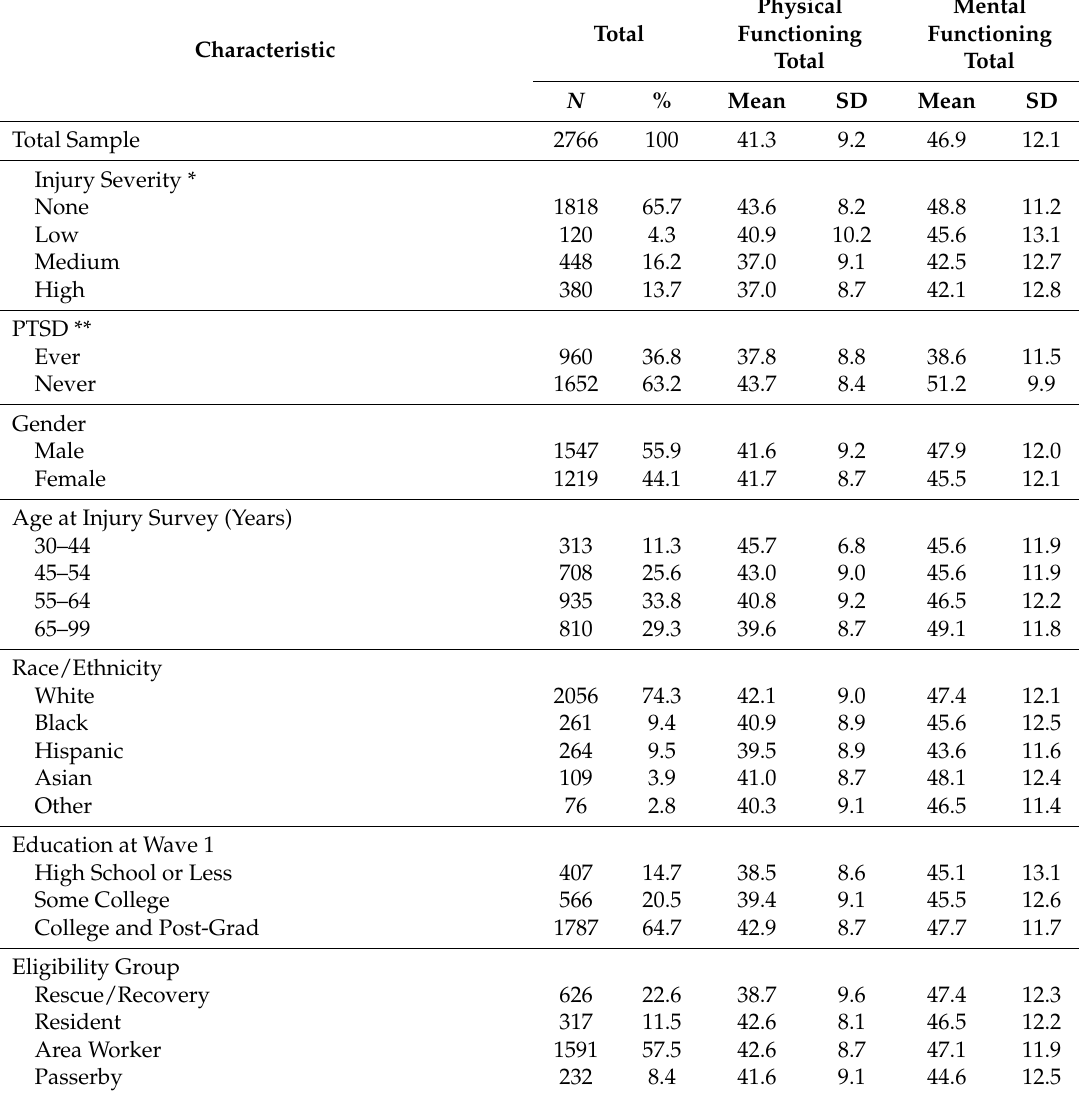
Table 2. Mean SF-12 Physical Health Component Scores (PCS-12) and mean Mental Health Component Scores (MCS-12) by injury severity, PTSD history, and other covariates.